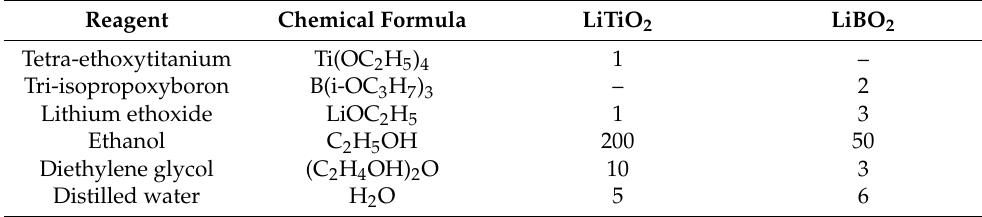
Table 1. Raw material information and molar ratio for synthesis of LiTiO 2 and LiBO 2